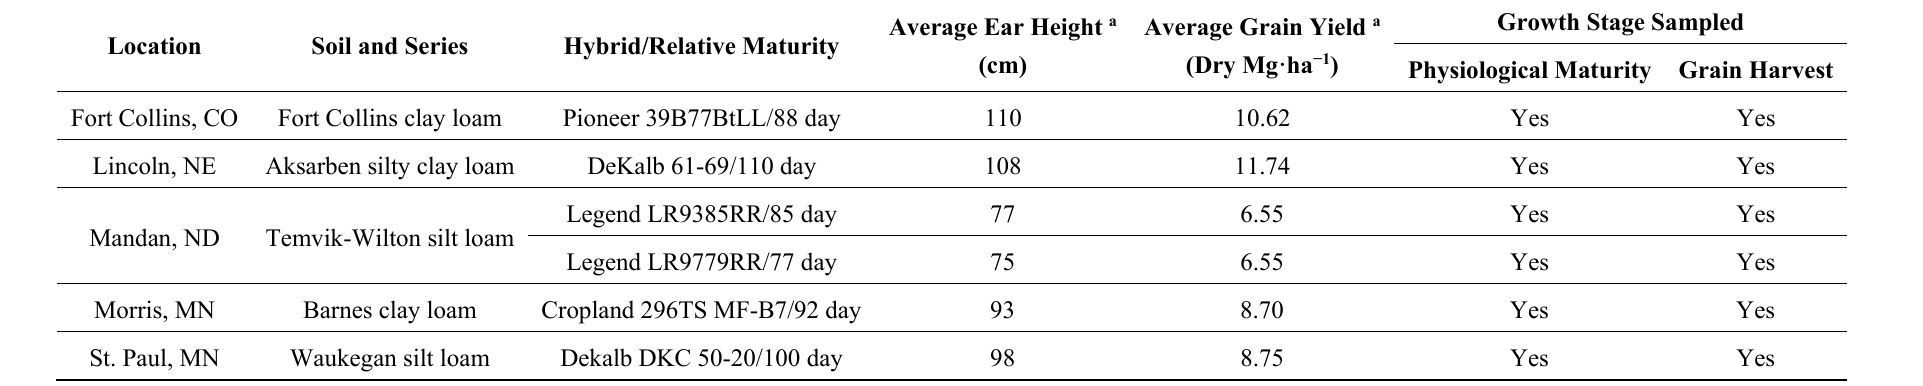
Table 1. Ancillary and descriptive data for the five U.S. locations from which corn plants were collected and analyzed for compositional analysis. Additional information was previously published